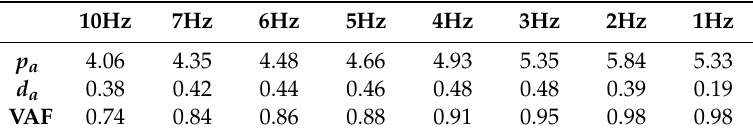
Table 6. Variation in reflex gains and reflex prediction VAF values of subject B with different low-pass cutoff frequencies.